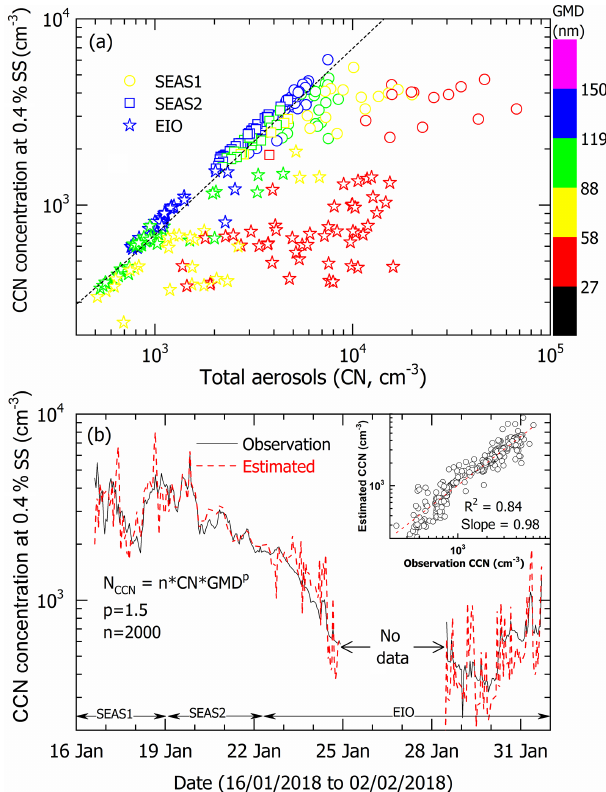
Figure 4. (a) Scatter plot between total aerosol (CN) and CCN at 0.4% supersaturation over SEAS1, SEAS2 and EIO. The colour shows the geometric mean diameter (GMD) of the aerosol size dis- tribution. Regression fit for a GMD greater than 100nm is shown as a black dotted line. (b) Temporal variation in CCN concentration at 0.4% supersaturation (SS) measured using a CCN counter and es- timated using the empirical relationship between total aerosol num- ber concentration and geometric mean diameter. The “ p ” and “ n ” are empirical constants estimated using the regression technique. The scatter plot of measured and estimated CCN concentration is shown